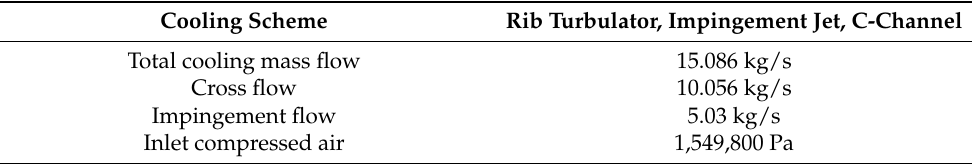
Table 2. Boundary condition for cooling flow simulation in model-2.